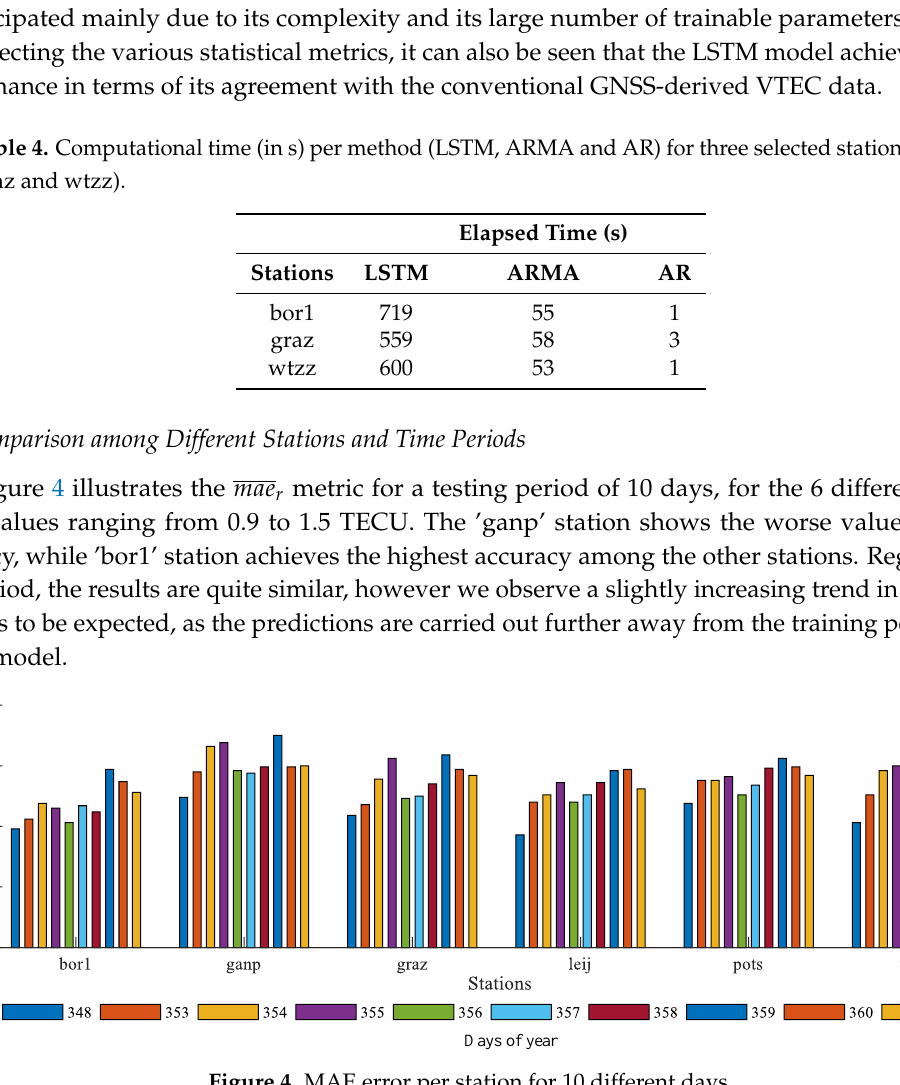
Figure 4. MAE error per station for 10 different